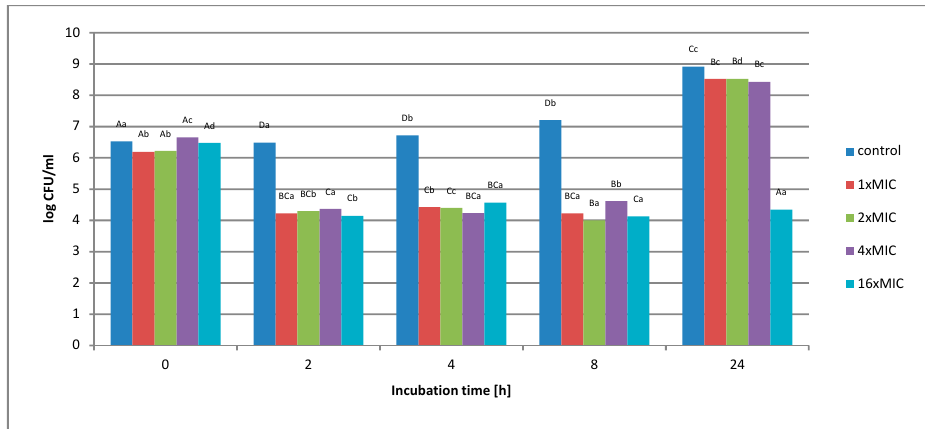
Figure 5. The effect of the aqueous extract at the concentration of 1 × MIC, 2 × MIC, 4 × MIC, and 16 × MIC on the survival of Salmonella Enteritidis in a matrix containing 3% meat extract during 24 h of incubation. A, B, C, D—the effect of matrix type on the change in the number of bacteria at the same time of storage; a, b, c, d—the effect of incubation time on changing the number of bacteria. The study found that the use of the extract at a concentration of 1 × MIC, 2 × MIC, and 4 × MIC did not inhibit the growth of the test bacterium after 24 h of incubation. Initially, a decrease in cell number was observed. The lower number of cells remained up to 8 h, while after this time an increase in the number of cells by about 4 log was observed. In turn, the use of an extract with a concentration of 16 × MIC (256 mg / mL) gradually reduced the number of S. Enteritidis cells in just 2 h of incubation from 3.0 × 10 6 CFU / mL to 1.4 × 10 4 CFU / mL. The value obtained after 2 h remained at a similar level until the end of the 24-h incubation.